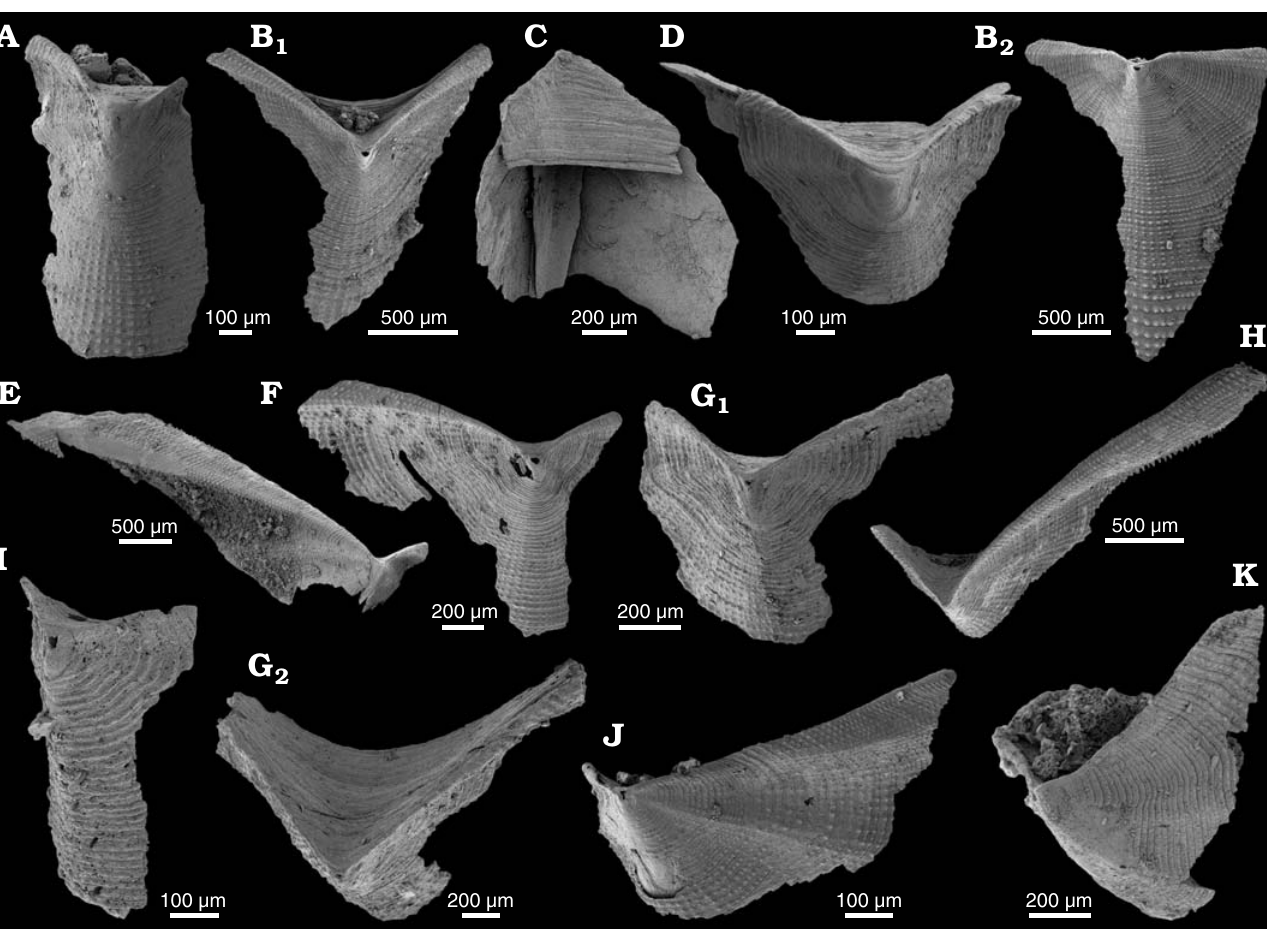
Fig. 15. The A1 sclerites of the camenellan tommotiid Dailyatia decobruta Betts sp. nov. from the lower Cambrian White Point Conglomerate, Kangaroo Island, South Australia. A . SAM P57329 in apical view. B . SAM P57330 in apical view (B 1 ); B 2 shows the broad, convex deltoid. C . SAM P57331 in ante- rior view. D . SAM P57332 in apical view. E . SAM P57333 in apical view. F . SAM P57334 in apical view. G . SAM P57335 in apical view (G 1 ); G 2 shows the concentric, wrinkled ornament on the anterior field. H . SAM P57336 in apical view. I . SAM P57337 in apical view. J . SAM P57338 in oblique lateral view. K . SAM P57339 in oblique lateral